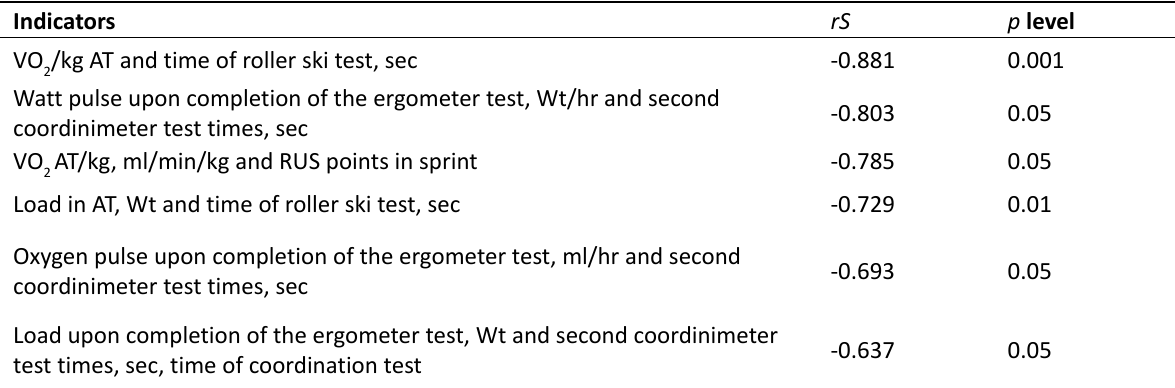
Table 3. Correlations between physical performance with special physical training and the competition results and results of the second coordination